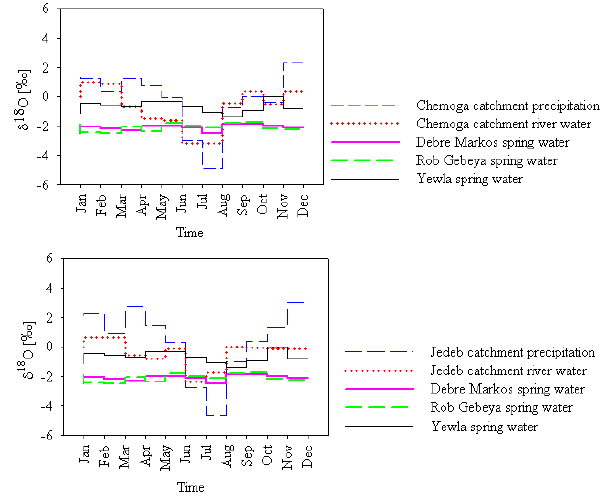
Figure 10. Monthly δ 18 O [‰] isotopic variation in amount- Fig. 10. Monthly δ 18 O [‰] isotopic variation of amount weighted precipitation, weighted precipitation, volume-weighted discharge and non- volume weighted discharge and non-weighted spring water a) Chemoga and b) Jedeb weighted spring water; (a) Chemoga and (b) Jedeb catchment for catchment for the period July 2009-August 2011. the period July 2009–August 2011.